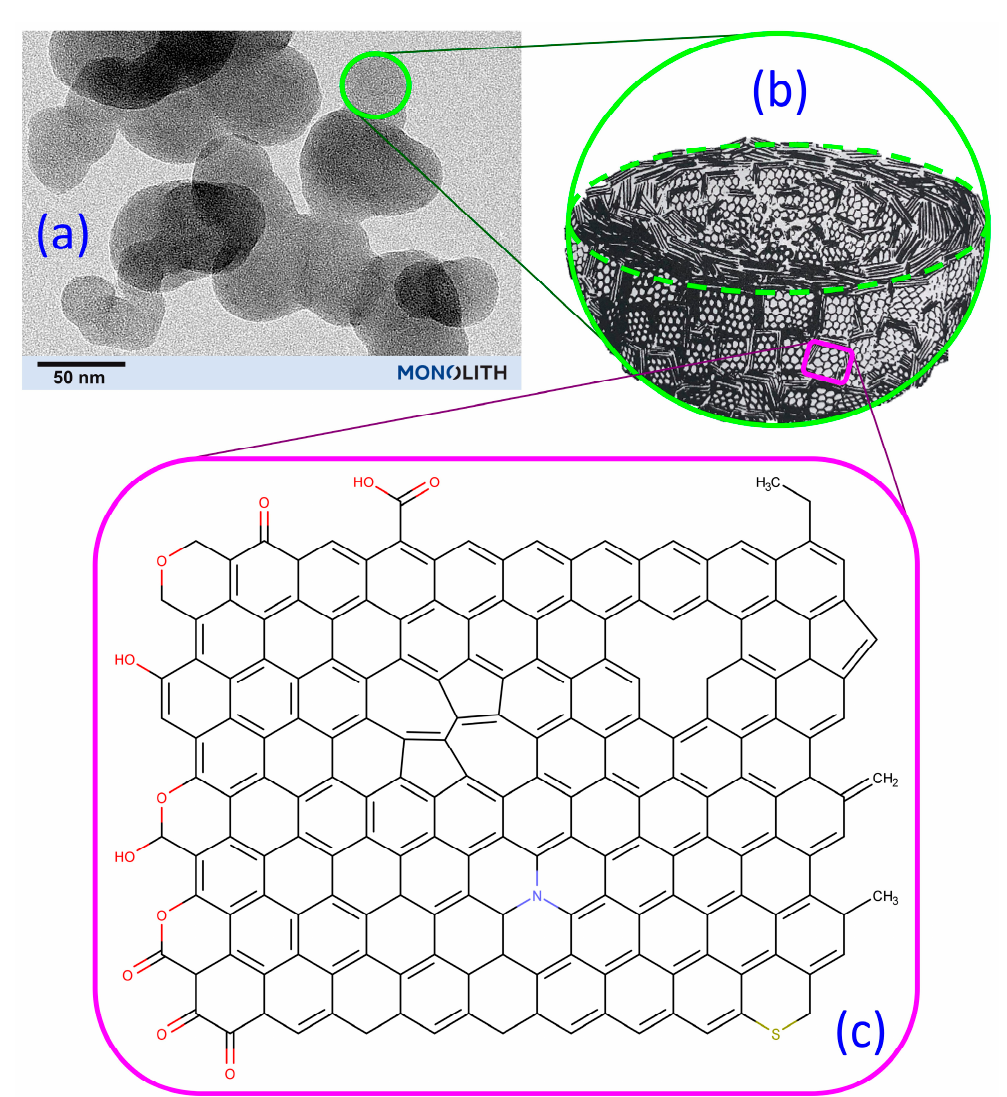
Figure 10. Different levels of structure and chemistry in carbon black: ( a ) TEM image of N660 carbon black at the indicated magnification; ( b ) schematic of a primary particle (cut in half to show the internal structure) that is composed of stacks of graphene sheets (adapted from Heidenreich et al. [48]); and ( c ) depiction of the different chemical groups on a graphene sheet in CB along with possible defects in the sheet. The various functional groups and defects are described in the discussion text. Table 2. Effects of Heat Treatment on CB Characteristics.